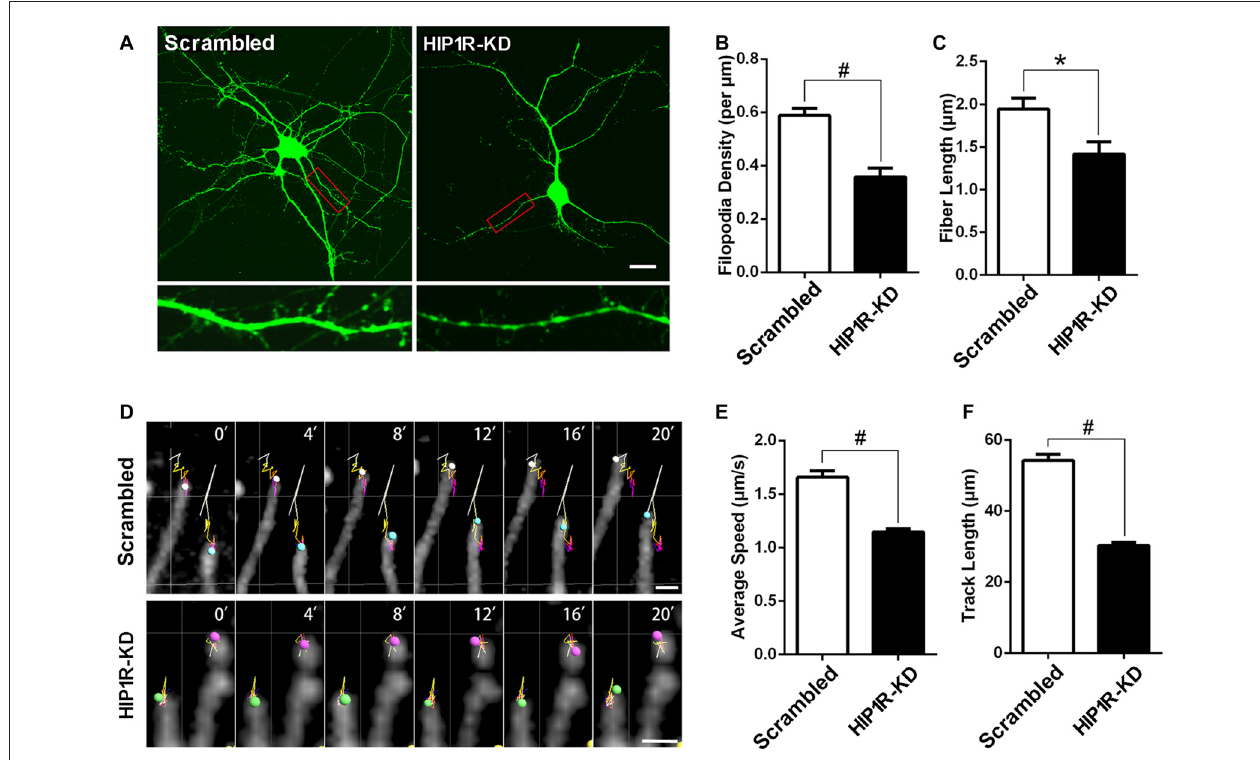
FIGURE 4 | HIP1R knockdown decreases dynamics and density of dendritic filopodia. (A–C) Cultured hippocampal neurons were transfected at DIV5 with HIP1R-shRNA and Scrambled vectors. Confocal fluorescence microscopy images were taken at DIV8 and used for analyzing spine morphology by MetaMorph software. Scale bar = 20 µ m (A) . Quantitative data showed both the density and length of dendritic filopodia were remarkably reduced in HIP1R-KD neurons compared to the scrambled control, with filopodia number per µ m: 0.36 ± 0.03, n = 30 vs. 0.59 ± 0.03, n = 65 (B) and filopodia fiber length: 1.42 ± 0.15 µ m, n = 30 vs. 1.94 ± 0.13 µ m, n = 65 (C) , respectively. (D–F) Time-lapse images of living transfected neurons were also taken for analyzing the dynamic activity of filopodia. The linear trajectory shows the movement pathway of each filopodium tip during 20 min and the size of the sphere represents the volume of the filopodium tip each minute. Scale bar = 10 µ m (D) . The average speed and track length of filopodia tips were obviously reduced in HIP1R-KD neurons compared to those of the control, with average speed: 1.15 ± 0.03 µ m/s, n = 177 vs. 1.66 ± 0.06 µ m/s, n = 166 (E) and track length: 30.25 ± 0.90 µ m, n = 177 vs. 54.23 ± 1.76 µ m, n = 166 (F) , respectively. Imaris software was used to track the tips of fibers in each min and analyze speed and track length. All data are represented as mean ± SEM, ∗ P < 0.05, # P < 0.0001.